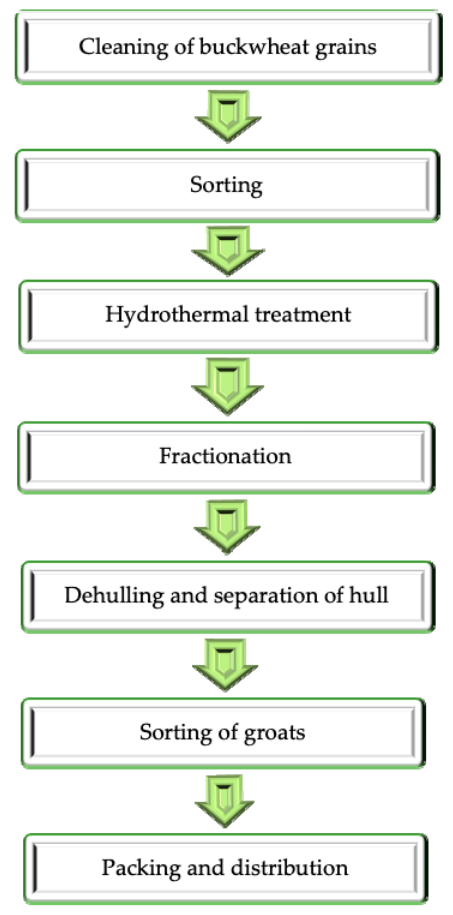
Figure 1. The scheme of buckwheat groats processing.